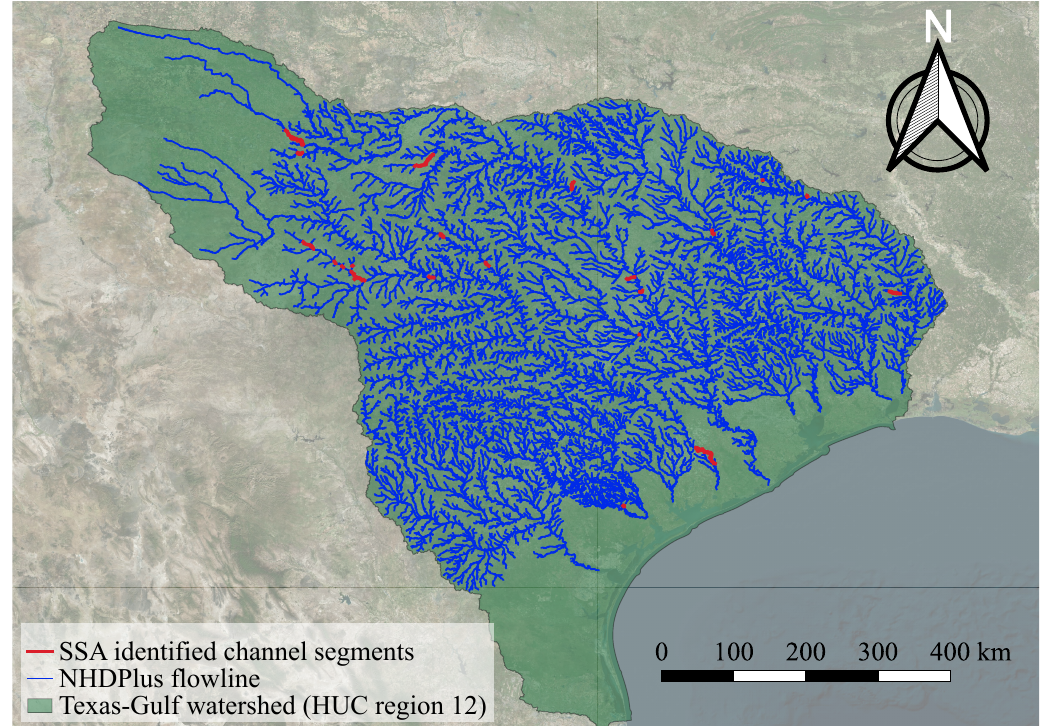
Figure 11. SSA method identified NHD flowlines with instability factors in bathymetry.